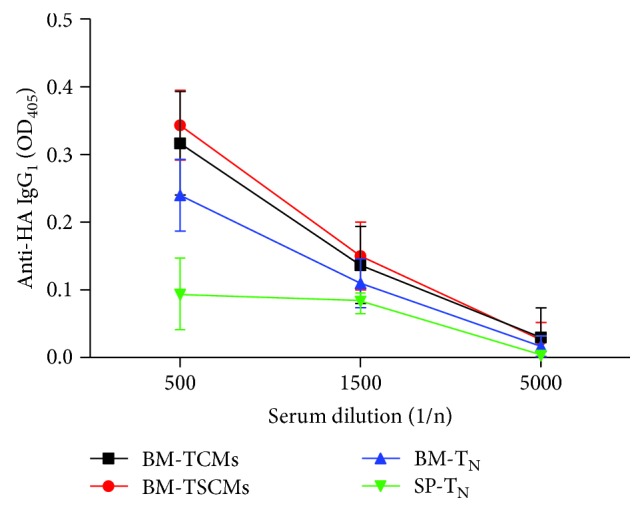
BM memory CD4+ TSCMs assist in affinity maturation of antibodies in vivo. Transferred CD4+ TSCMs from the BM provide help for affinity maturation of antibodies in vivo. 4 × 106 CD19+ CD138− CD4− cells (naïve B cells) from OT-II mice SP were transferred with 1 × 105 CD4+ CD44low CD62Lhigh CD122high Sca-1high T cells from the BM or SP of OT-II mice, into CD45.1 mice. One day later, recipients were immunized with 2000 hemagglutination units PR8-OVA in CFA. The blood taken from transferred mice 5 days later was analyzed for anti-HA IgG1 by ELISA. Data are representative of three independent experiments, means ± SD. n = 6.